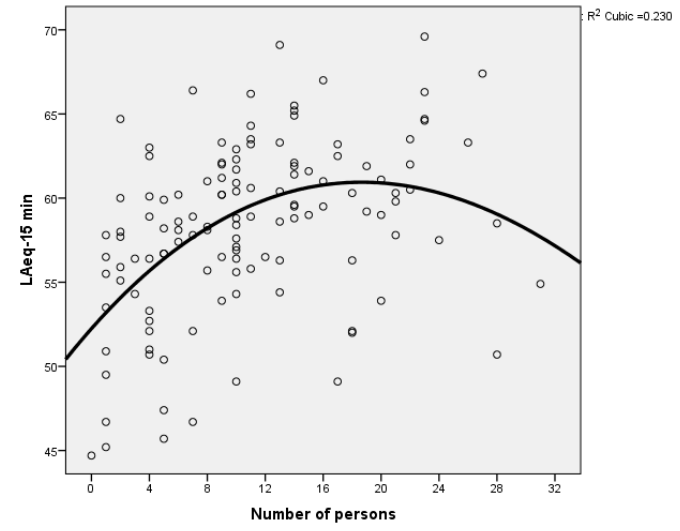
Figure 17. Scatter-plot of the L Aeq-15min scores as a function of the number of persons, with cubic fit for all data aggregated.